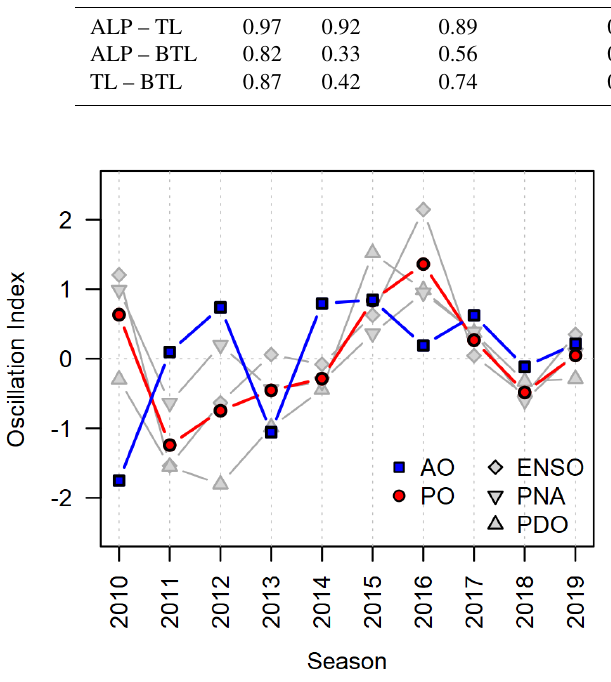
Figure 3. Winter season (November–April) average climate in- dices during the study period (ENSO: El Niño–Southern Oscilla- tion; PNA: Pacific North America Teleconnection Pattern; PDO: Pacific Decadal Oscillation; AO: Arctic Oscillation; PO: averaged Pacific-centered